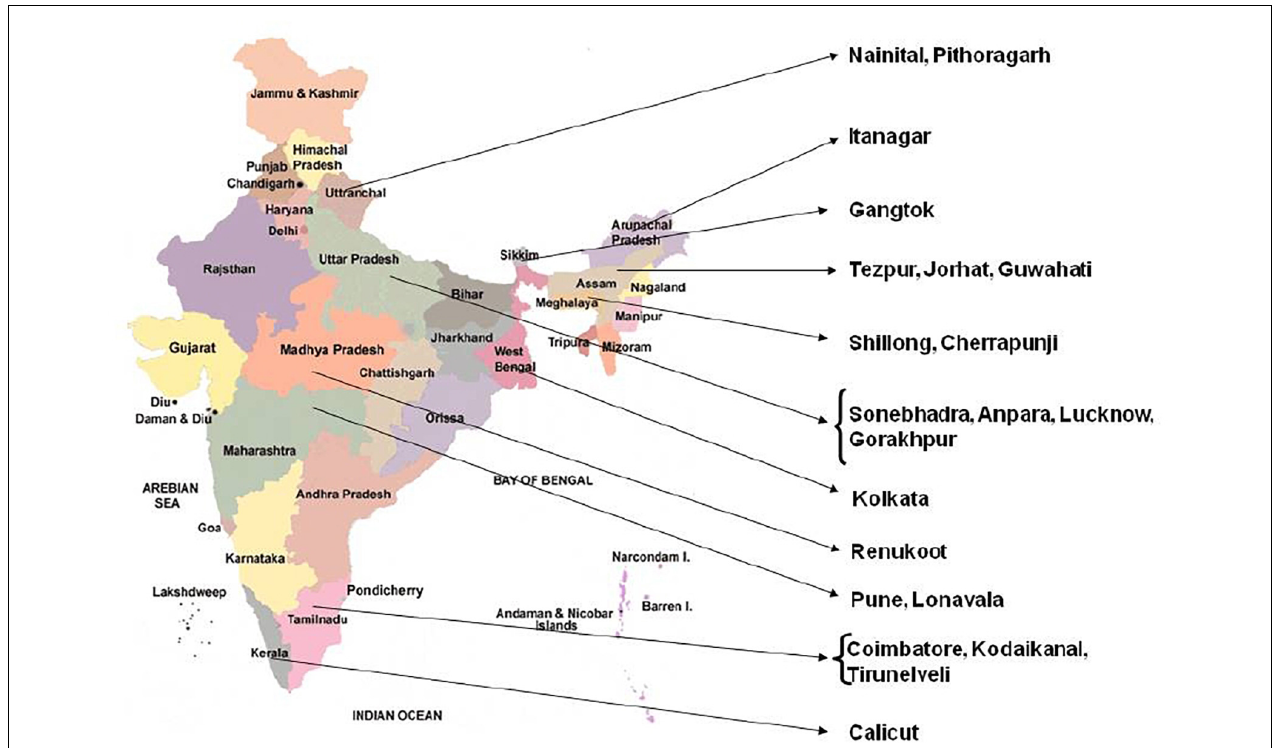
FIGURE 1 | Map of India showing different locations of collected Pteris